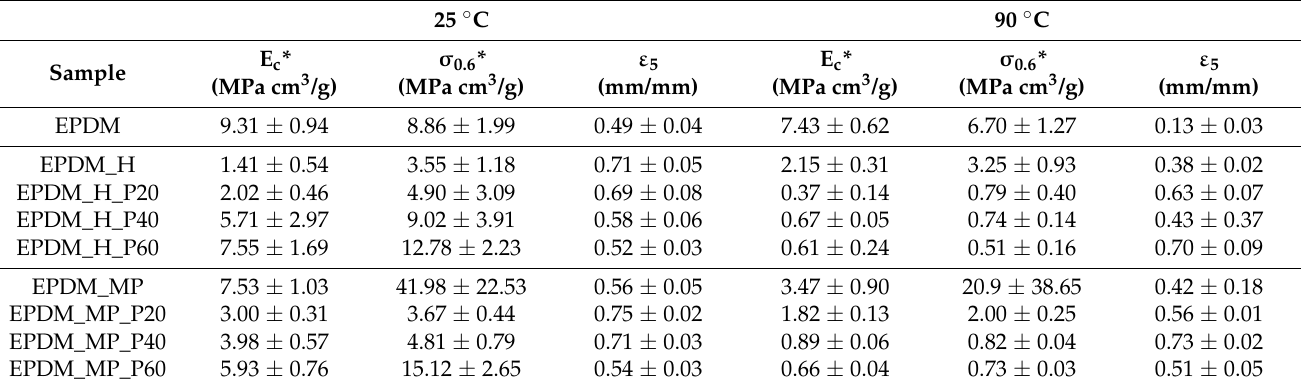
Table 9. Results of the quasi-static compression tests on the prepared